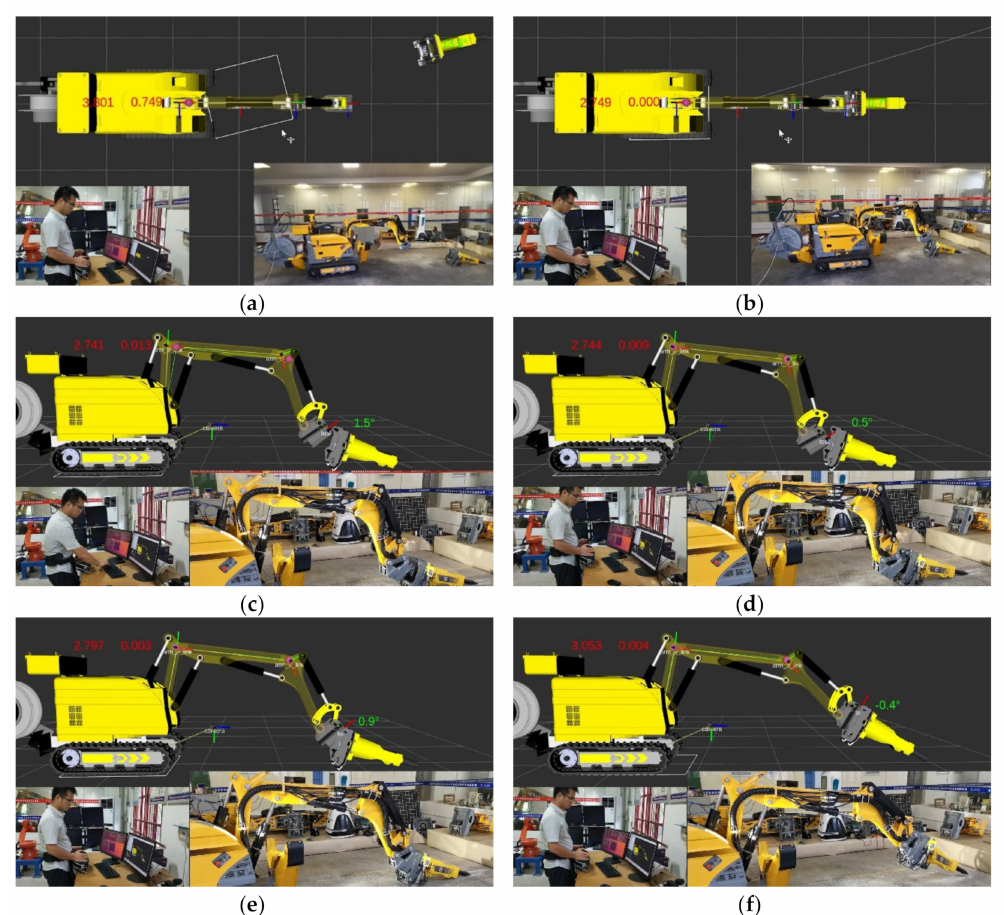
Figure 11. Experiment of attachment changing with trajectory planning. ( a ) Position determination of { T }. ( b ) Completion of initialization. ( c ) Trajectory planning. ( d ) The optimal docking position. ( e ) Completion of range alignment. ( f ) Completion of angle